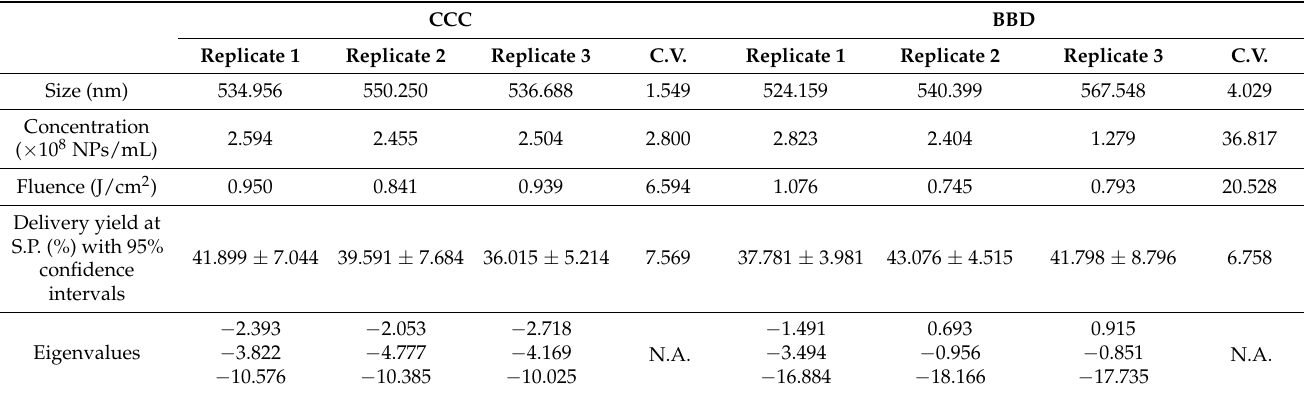
Table 3. Summary of the stationary points (S.P.) of all replicates for both the CCC design and BBD in original units, delivery yield at the S.P., coefficients of variation (C.V.) and all corresponding eigenvalues, providing more information on the nature of the S.P.